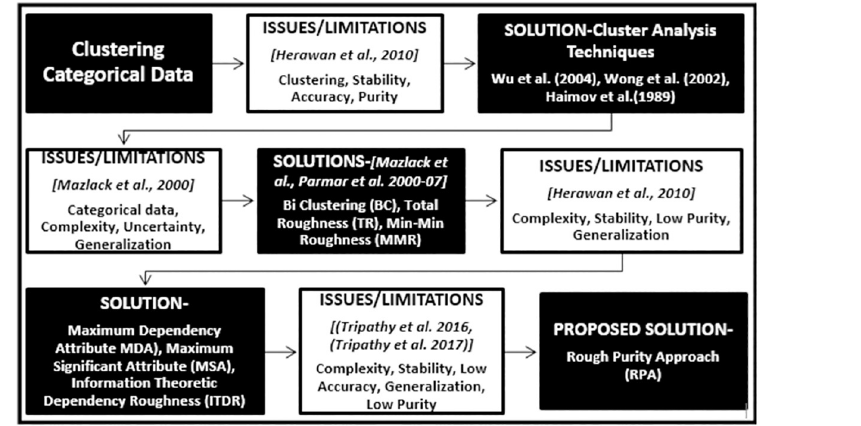
Fig 1. Scenario leading to the proposed framework.